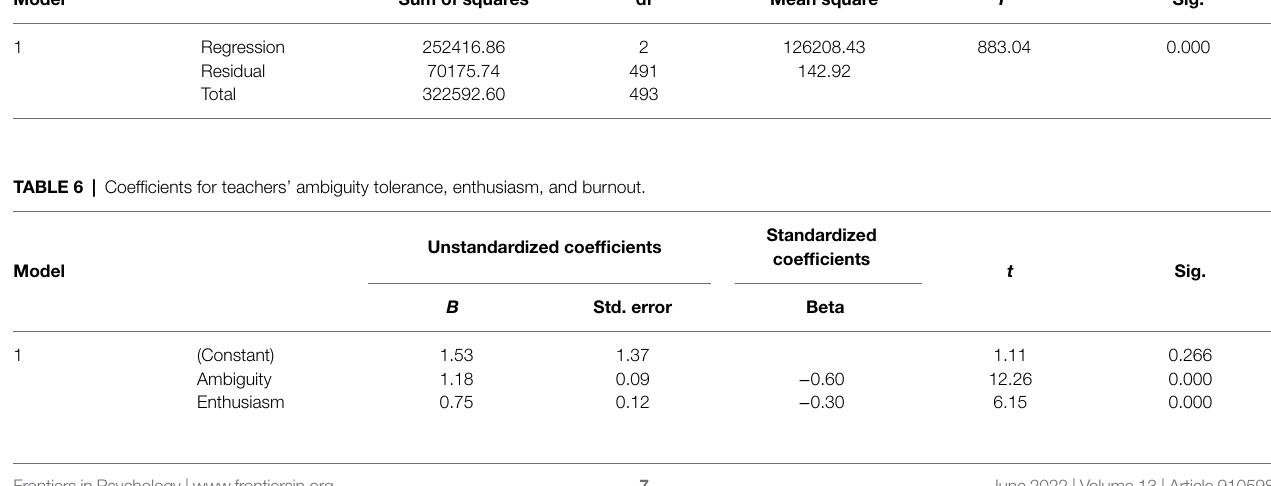
TABLE 5 | ANOVA for teachers’ ambiguity tolerance, enthusiasm, and burnout. Model